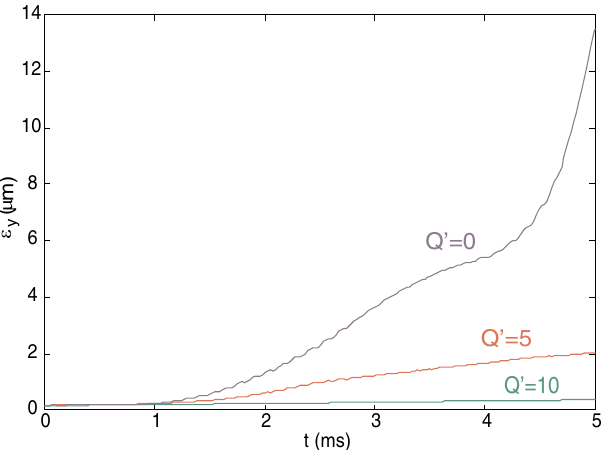
FIG. 53. (Color) Simulated vertical emittance of an SPS bunch at injection as a function of time over 5 ms for three different values of the vertical chromaticity; a broadband resonator im- pedance and space charge are included in addition to the electron cloud [85]; the simulation was performed with the HEADTAIL code.